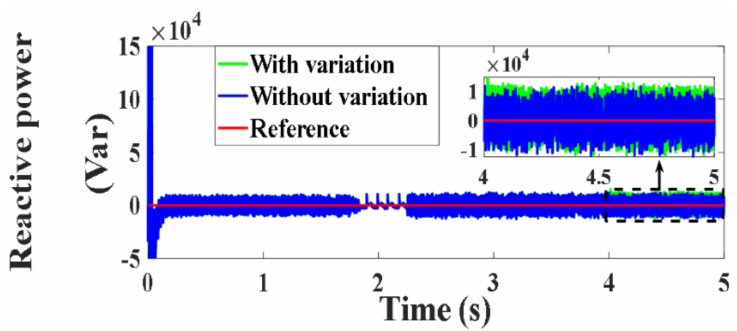
Figure 92. Reactive power under PVC